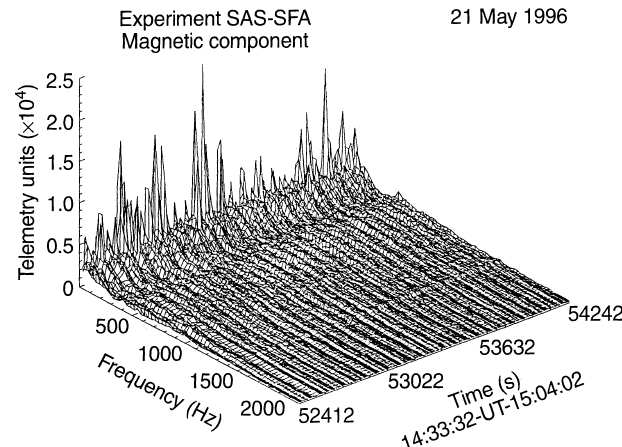
-component) Fig. 4 . The same as in Fig. 2 for the magnetopause crossing on 21 x May. The sharp enhancement at the lowest frequency can be seen at 14:39, 14:45 and 14:58 UT. The co-ordinates of the satellite were r (cid:136) 10.4–11.7 R , 18.57, 3.3 (cid:176) . E